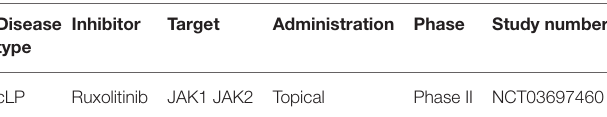
TABLE 7 | Trial on JAKi in lichen